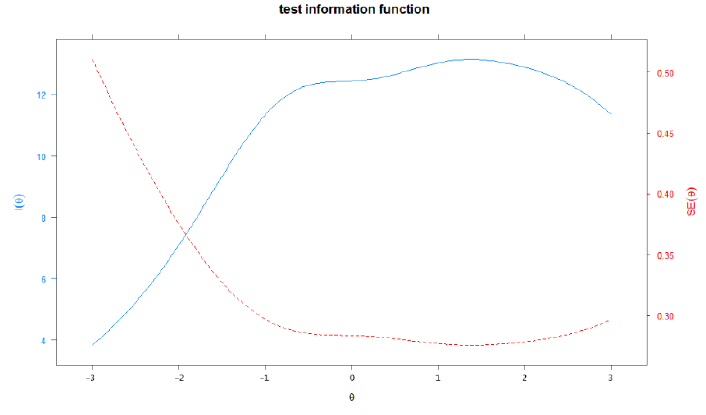
Figure 2. Test information of D28 ‐ C.